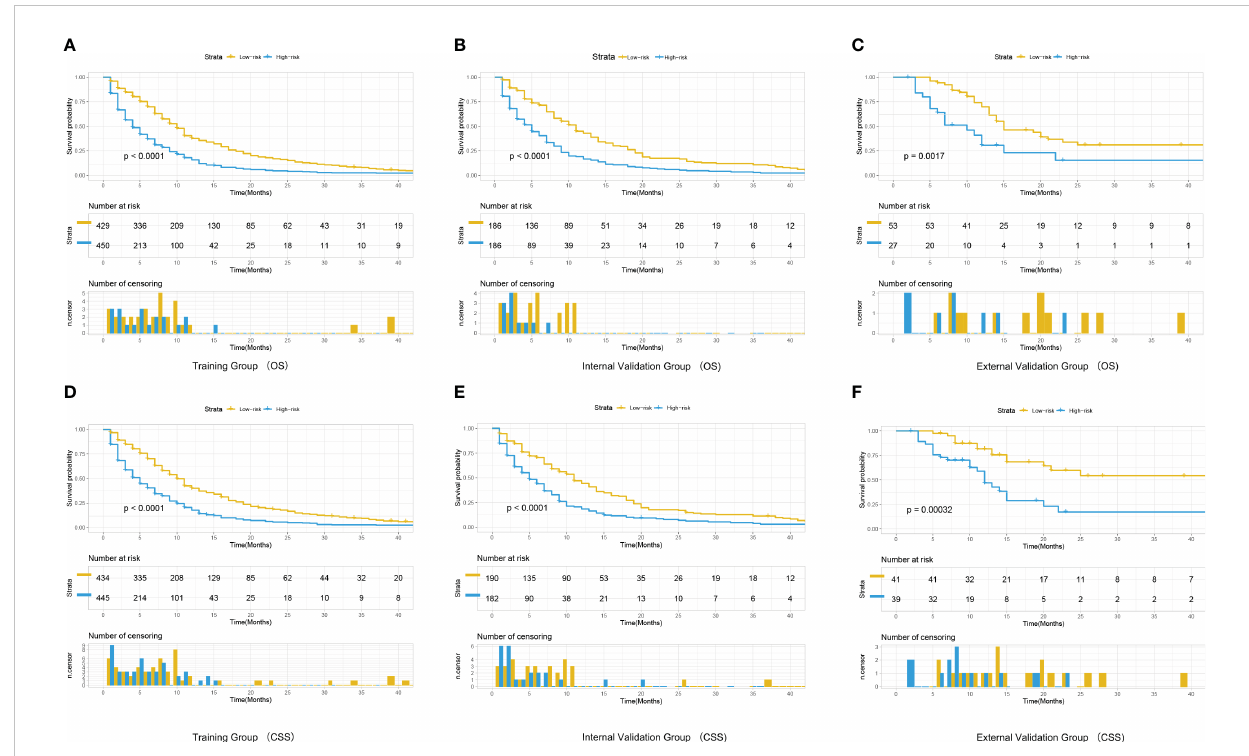
FIGURE 6 Kaplan-Meier curves for correlation with OS for the low and high- risk groups in the training cohort (A) , internal validation cohort (B) and external validation cohort (C) Kaplan-Meier curves for correlation with CSS for the low and high-risk groups in the training cohort (D) , internal validation cohort (E) and external validation cohort (F)